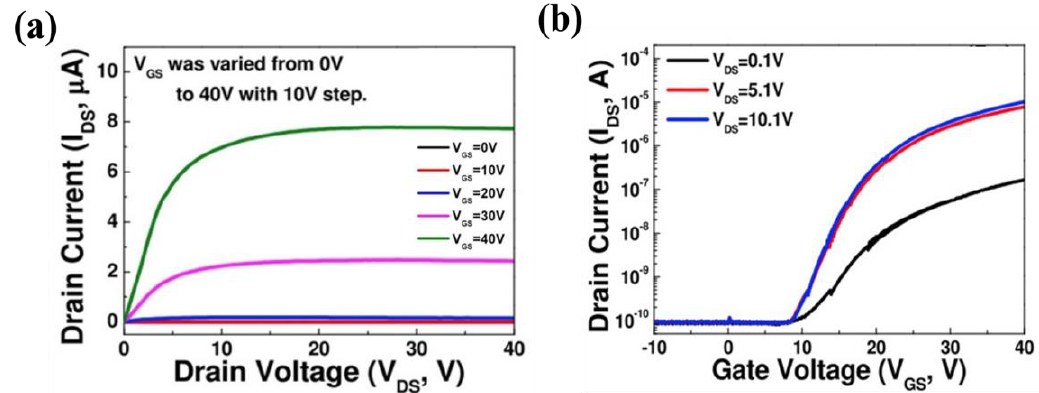
Figure 6. ( a ) Output characteristics and ( b ) transfer characteristics of the a-IGZO TFT subjected to microwave-assisted annealing at 200 °C. The microwave-assisted process utilizing the dipole rotation mechanism is a more efficient method than conventional thermal annealing in terms of the reduction in the proportion of defect states and low-temperature process.